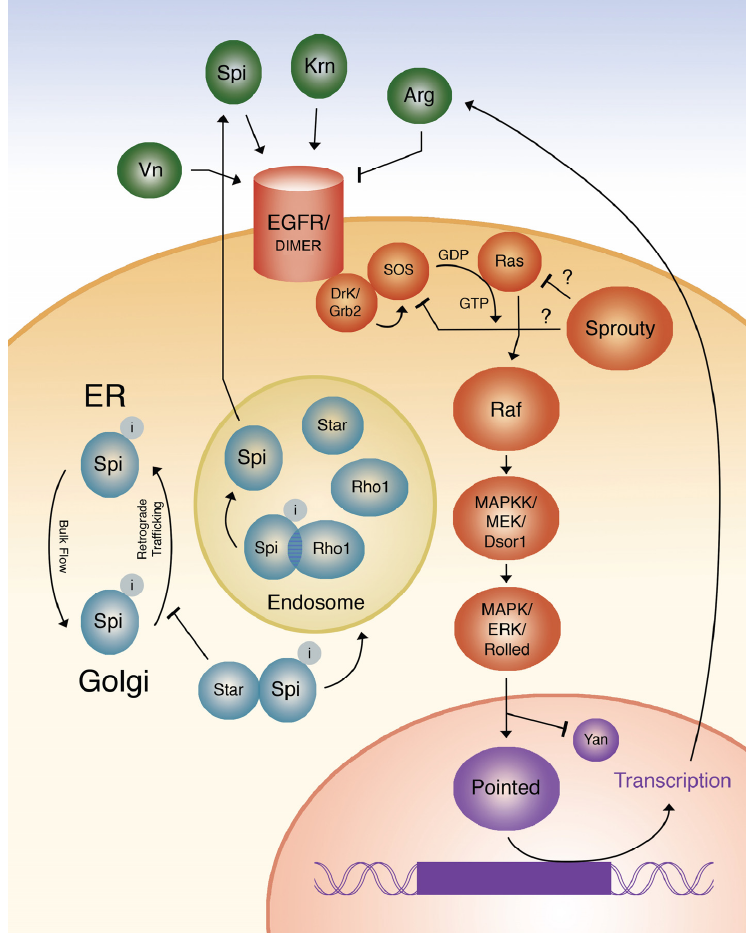
Figure 1. Diagrammatic representation of the EGF signaling pathway. Question marks refer to the still unknown mechanism of Sprouty action.